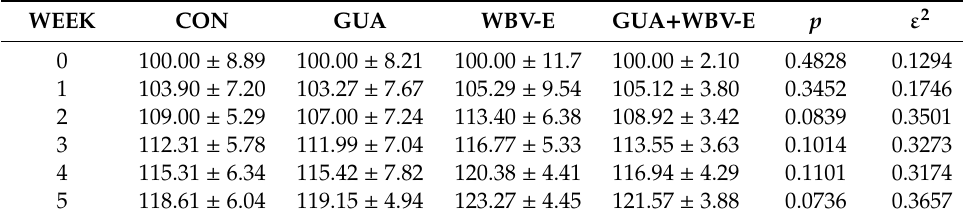
Table 4. Body mass (%) of the animals submitted to some interventions.